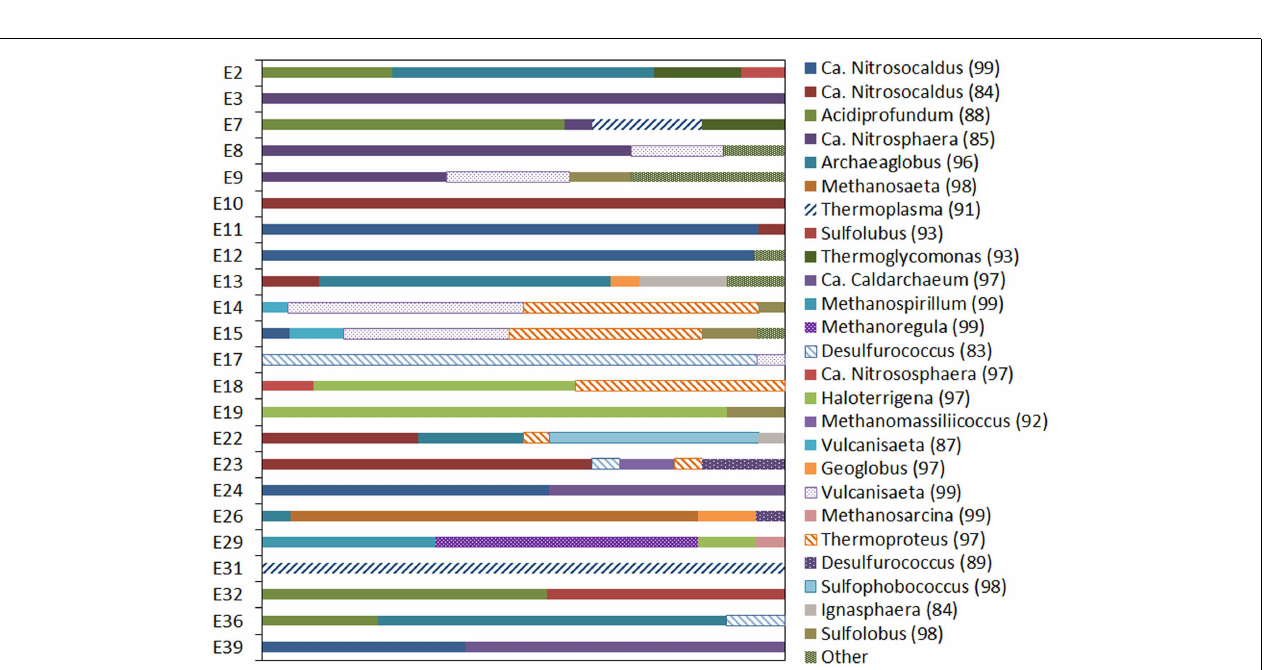
FIGURE 4 | Principle coordinates (PCO) analysis of Rao phylogenetic dissimilarity of archaeal 16S rRNA genes recovered from 22 geothermal sediments and mats with the pH of each system overlaid with color for each data point (A). Plot depicting relationship between PCO axis 1 coordinates and environmental pH (B) . A complete listing of the taxonomic composition of environments where archaeal 16S rRNA genes were